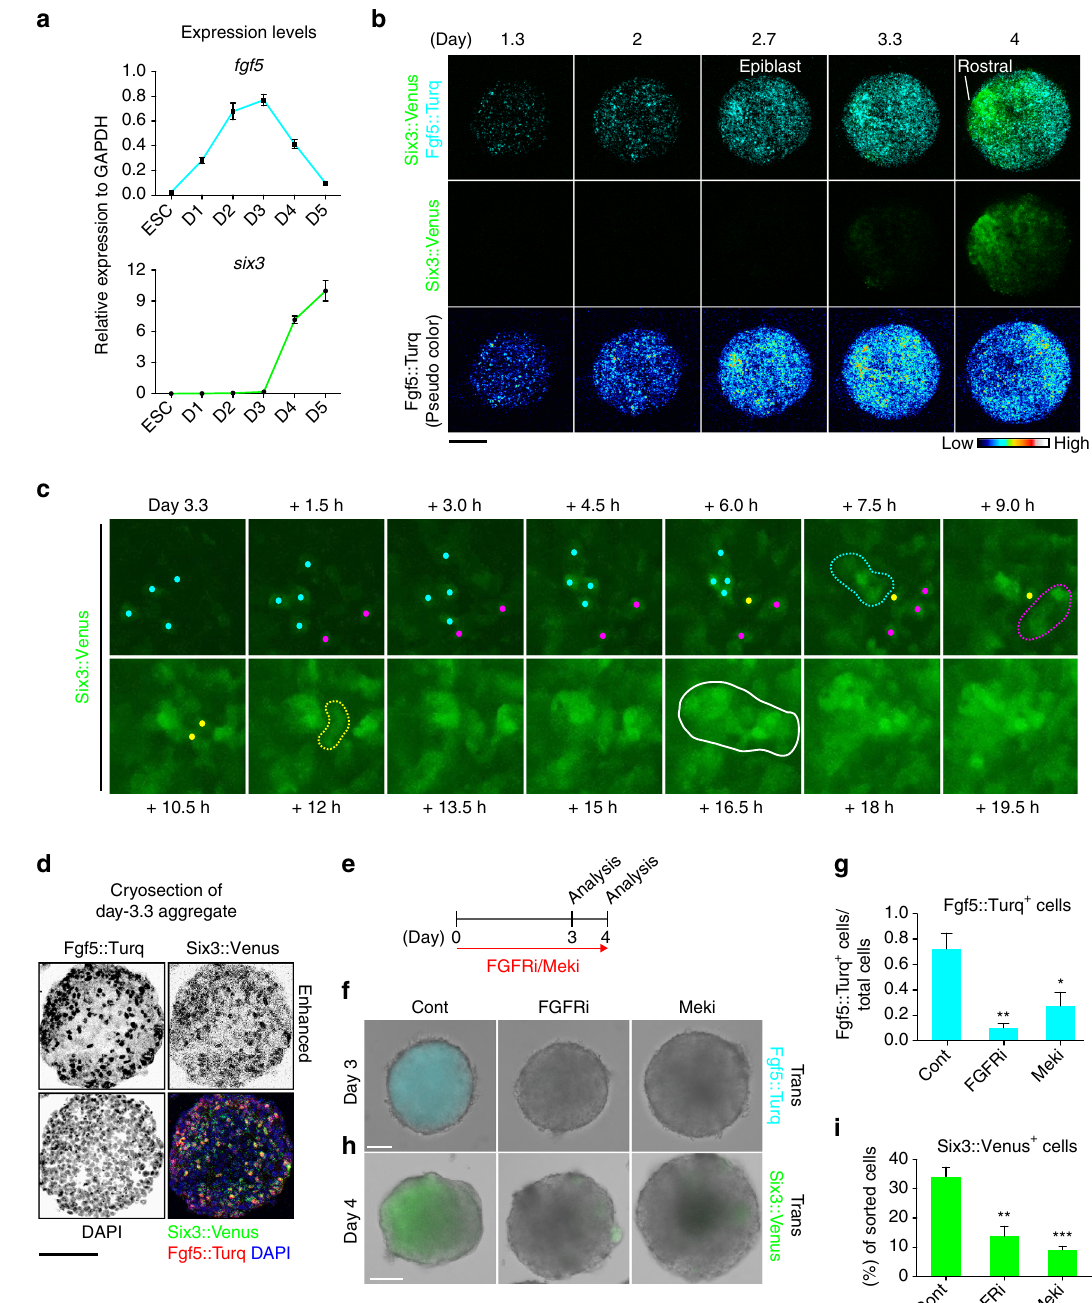
Fig. 2 FGFR/Mek signaling is required for the differentiation of Fgf5 + epiblast-like cells. a Quanti fi cation of fgf5 and six3 expression via RT-qPCR from days 0 to 5 of embryonic stem cell (ESC) culture. D, day. b Montage of images taken from Supplementary Movie 3, showing upper panel; merged image of Six3:: Venus and Fgf5::Turq (monomeric Turquoise2-HA-NLS), middle panel; Six3::Venus, lower panel; pseudo color of Fgf5::Turq. c Time-lapse imaging of Six3:: Venus + cells. Each color dot indicates a cell that is a component of each Six3 + small cluster. Broken lines (cyan, magenta and yellow) indicate each Six3 + small cluster. White solid line indicates a large cluster. d Immunohistochemistry against Venus and HA epitope (monomeric Turquoise2-HA-NLS) was performed on cryosections of day-3.3 aggregates, showing Six3::Venus and Fgf5::Turq signals. Six3::Venus signals were enhanced by the auto contrast function of ImageJ to see a dim expression. e Diagram of pharmacological inhibition of FGFR and Mek (FGFRi and Meki) by PD173074 and PD0325901, respectively. f , h Merged images of transillumination (Trans) and Fgf5::Turq ( f ) or Six3::Venus ( h ). g Quanti fi cation of Fgf5::Turq-HA-NLS positive cells via ImageJ analysis (See Methods). Total cells were counted by DAPI signals. i Quanti fi cation of Six3::Venus + cells via FACS. Error bars indicate s.e.m of each experiment ( a , g , i ). Signi fi cance was determined using Dunnett ’ s test ( g , i ). * P < 0.05; ** P < 0.01; *** P < 0.001. Cont, control. Scale bars, 100 µ m ( b , d , f , h ). These images were one of n = 3 experiments ( b , c , d , f , h